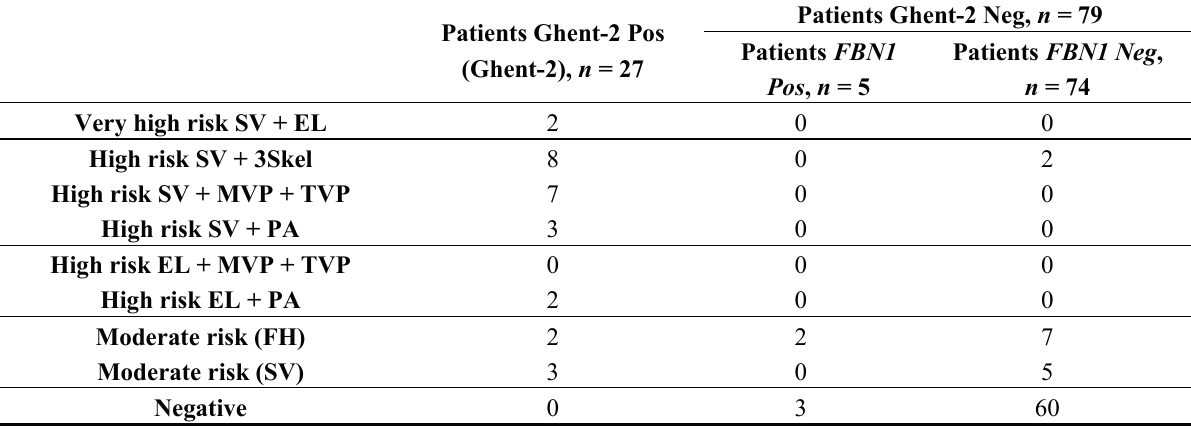
Table 5. Comparison of risk stratification with Kid-SMS and diagnosis according to Ghent-2 at follow-up visit. (Ghent-2 Pos, revised Ghent Criteria positive; Ghent-2 Neg, revised Ghent Criteria negative; FBN1 Pos , FBN1 mutation positive; FBN1 Neg , FBN1 mutation negative; SV, dilatation of sinus of valsalvae; PA, dilatation of pulmonary artery; MVP, mitral valve prolapse; TVP, tricuspid valve prolapse; 3Skel, at least 3 skeletal features of the systemic score of the revised Ghent Criteria; EL, ectopia lentis; FH, family history). Patients Ghent-2 Pos